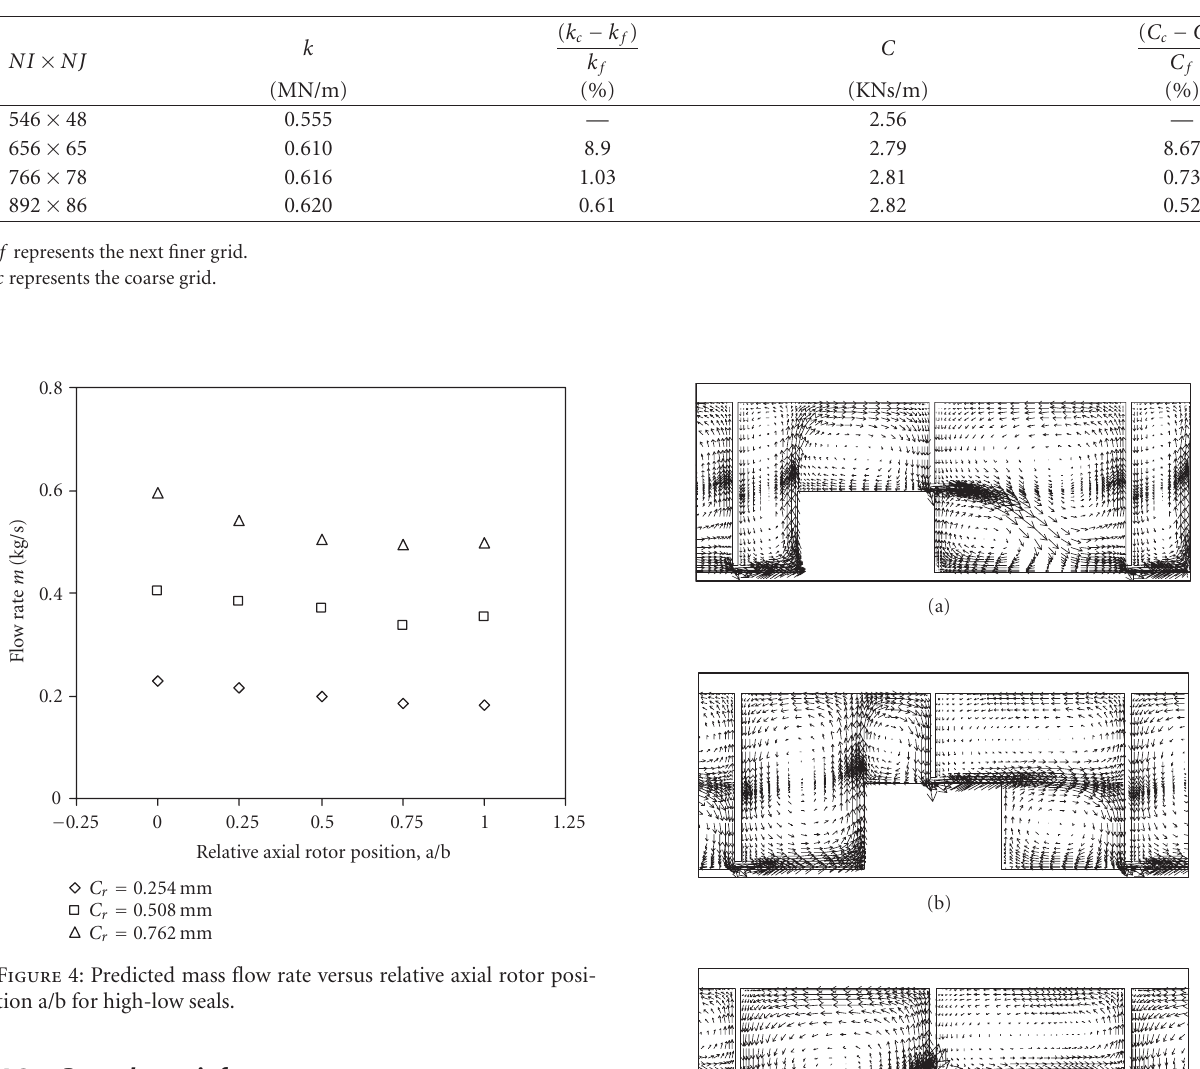
Table 2: Grid independence testing results.